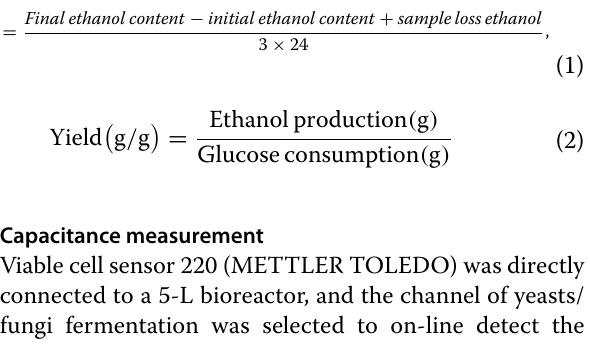
Glucose feeding strategy